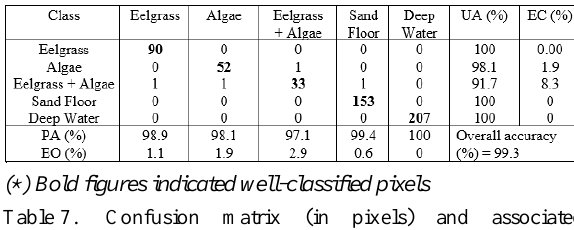
Confusion matrix (in pixels) and associated accuracies when the RF classifier is applied to all the Sentinel-2 image